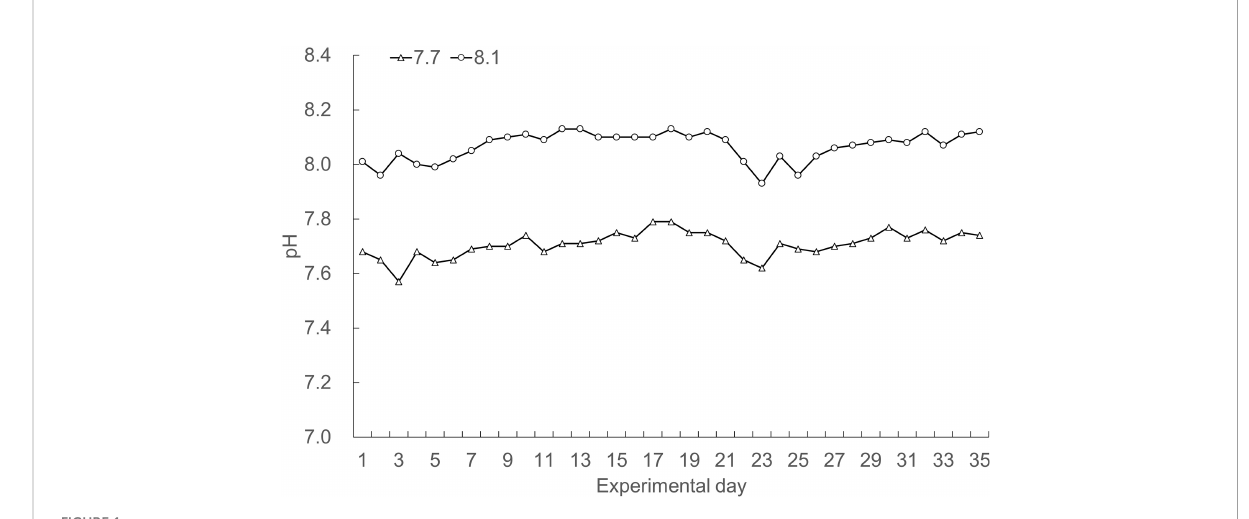
FIGURE 1 Daily records of seawater pH over the course of the